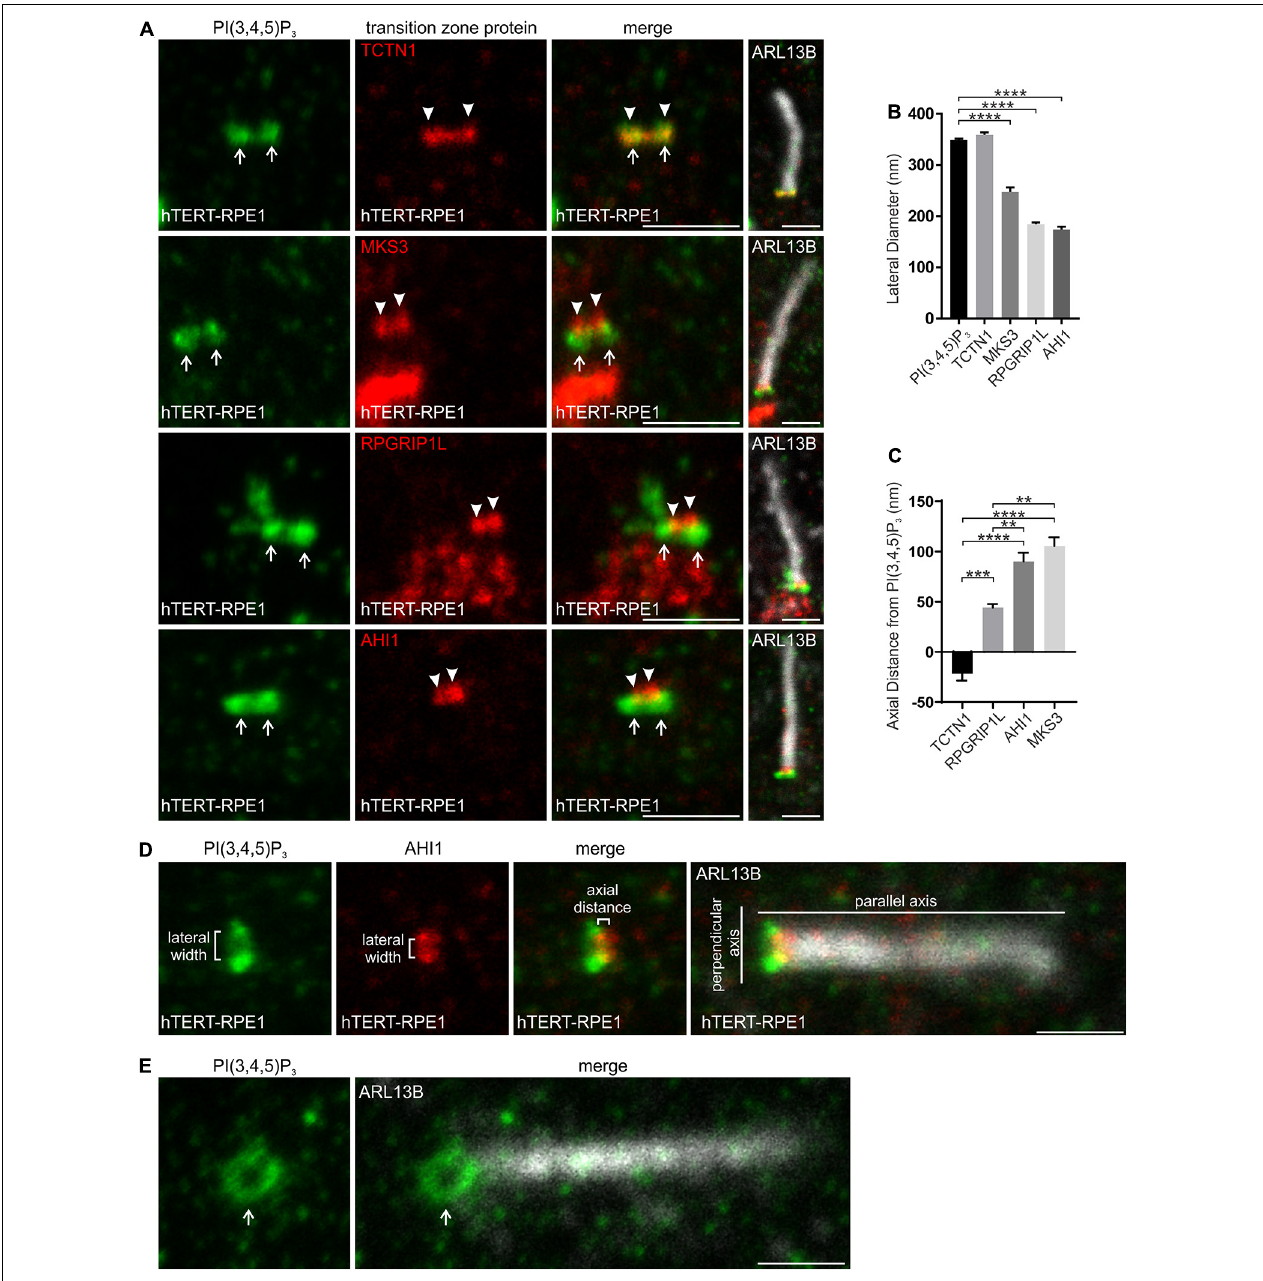
FIGURE 3 | PI(3,4,5)P 3 localizes to a specific subdomain of the transition zone. (A) Ciliated hTERT-RPE1 cells were immunostained with PI(3,4,5)P 3 (green), ARL13B (grayscale) and TCTN1, MKS3, RPGRIP1L or AHI1 (red) antibodies and imaged by STED microscopy (confocal resolution image of the ARL13B stained axoneme is shown). Right panels show merged image at lower magnification. Arrows indicate transition zone PI(3,4,5)P 3 signal, arrow heads indicate transition zone protein localization, bar indicates 1 µ m. (B) Graph shows the lateral diameter between the highest intensity points of the PI(3,4,5)P 3 or transition zone protein puncta perpendicular to the plane of the axoneme. Bars represent mean ± SEM, n = 3 independent experiments, 30 cilia imaged per experiment and all cilia with two distinct PI(3,4,5)P 3 or transition zone protein puncta measured, statistical significance was determined using one-way ANOVA ( p < 0.0001) followed by Tukey’s post hoc test, **** p < 0.0001. (C) Graph shows the axial distance between the highest intensity point of the PI(3,4,5)P 3 signal and each transition zone protein signal parallel to the plane of the axoneme. Bars represent mean ± SEM, n = 3 independent experiments, 30 cilia imaged per experiment and all cilia with distinct PI(3,4,5)P 3 or transition zone protein puncta measured, statistical significance was determined using one-way ANOVA ( p < 0.0001) followed by Tukey’s post hoc test, ** p < 0.01, *** p < 0.001, **** p < 0.0001. (D) Representative image showing the method used for the lateral diameter and axial distance measurements, bar indicates 1 µ m. (E) Ciliated hTERT-RPE1 cells were immunostained with PI(3,4,5)P 3 (green) and ARL13B (grayscale) antibodies and imaged by STED microscopy (confocal resolution image of the ARL13B stained axoneme is shown). Arrow indicates ring shaped transition zone PI(3,4,5)P 2 morphology, bar indicates 1 µ m.